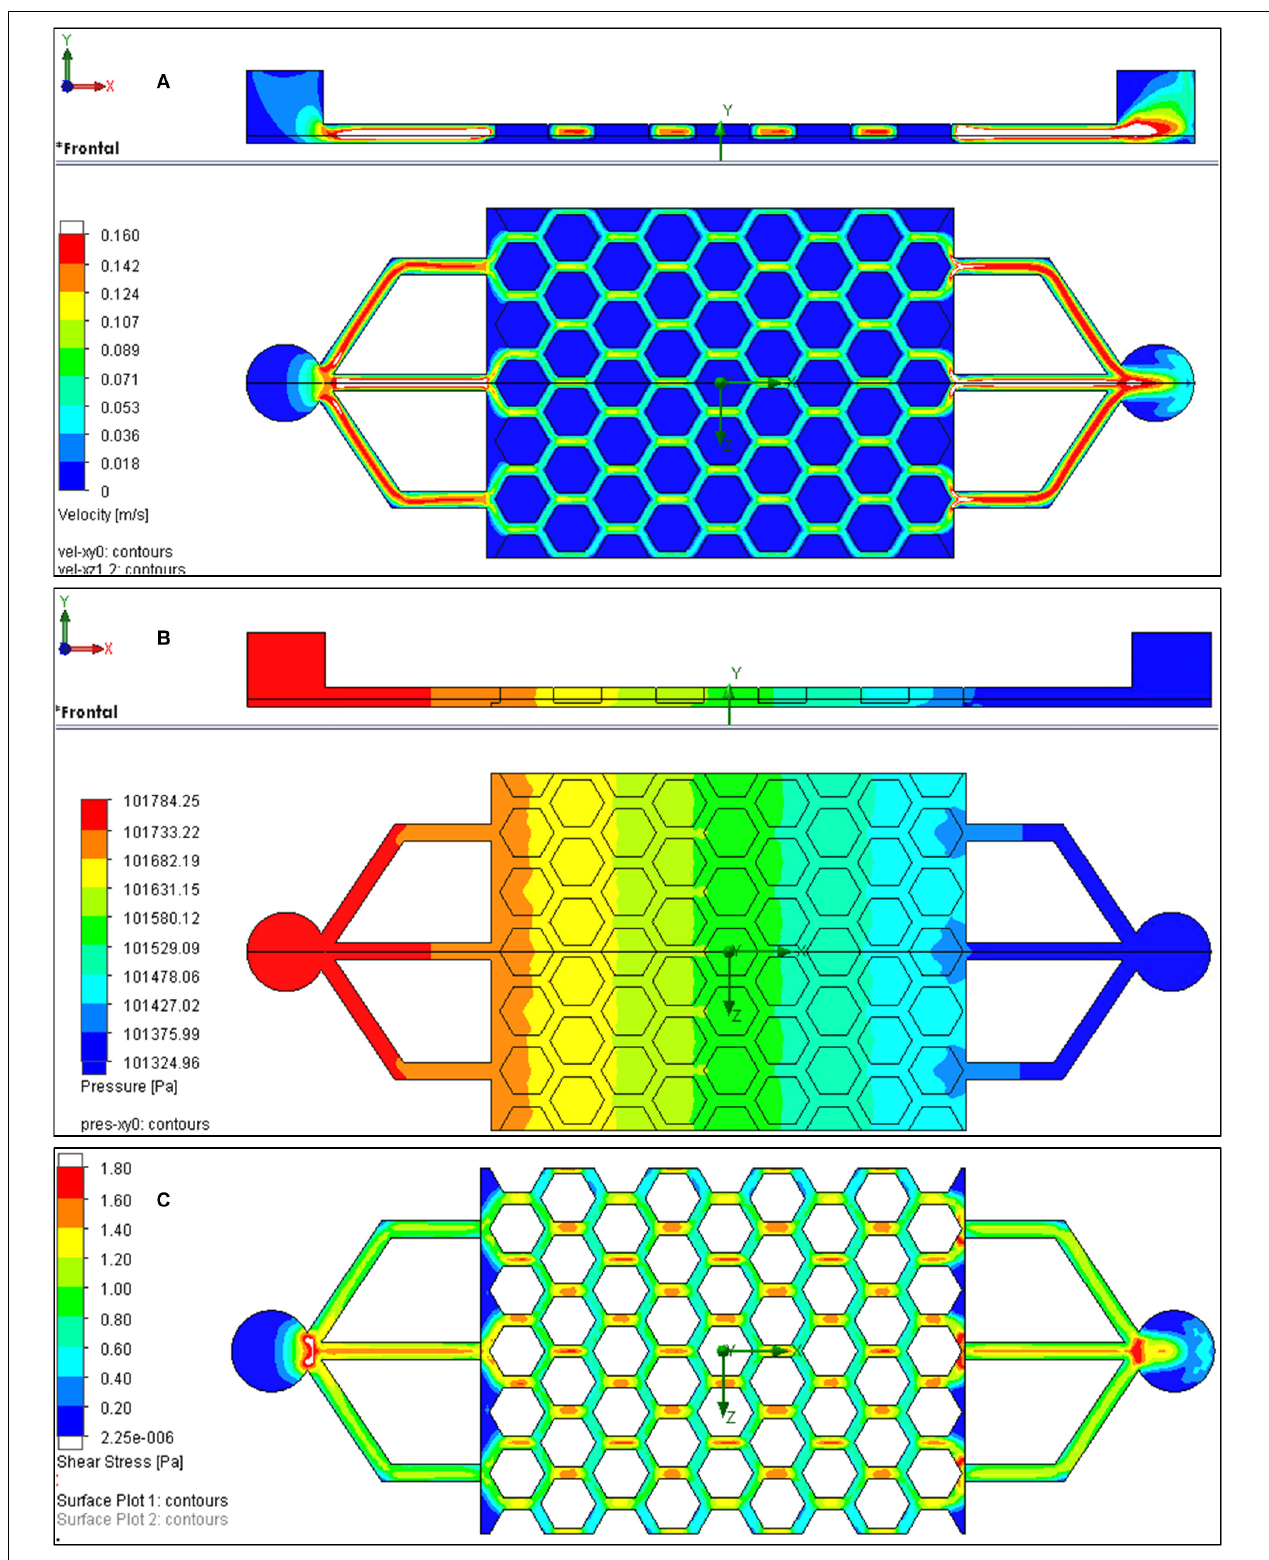
FIGURE 8 | Computational fluid dynamics (CFD) results for the bone microfluidic chip at inlet flow rate of 3.2 mL/min. (A) Velocity and (B) pressure as media passes through the chip (left to right). (C) Shear stresses at the bottom of the channels if the polyHIPE is assumed to be non-porous.